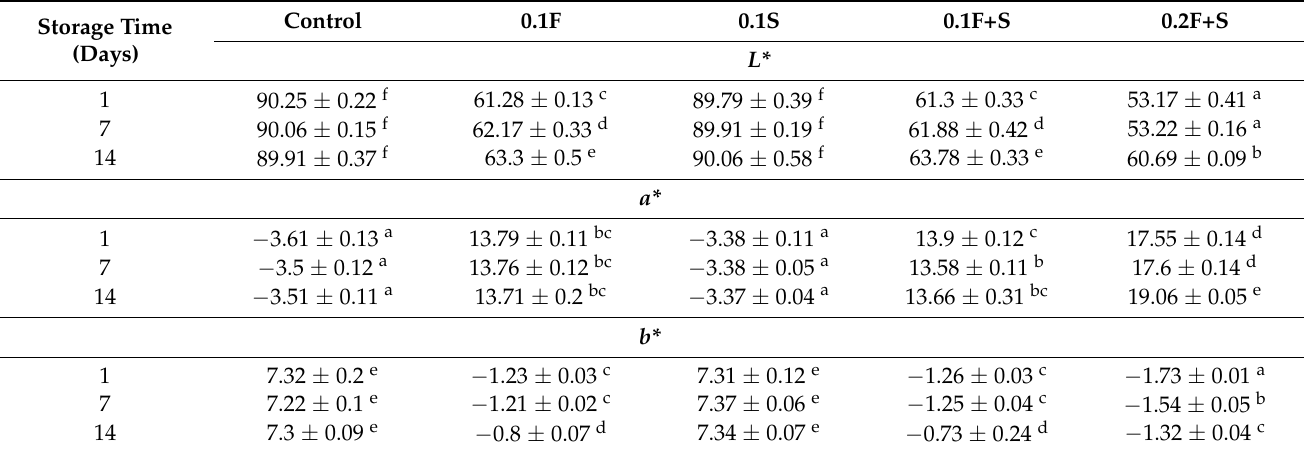
Table 2. Changes in color parameters of yoghurts during